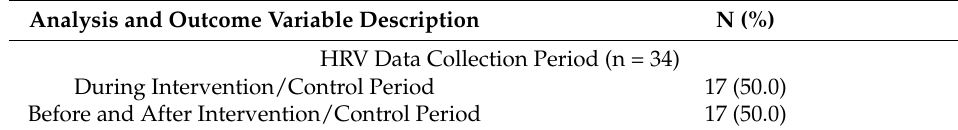
Table 4. Characteristics of HRV Analysis Methods and Outcome